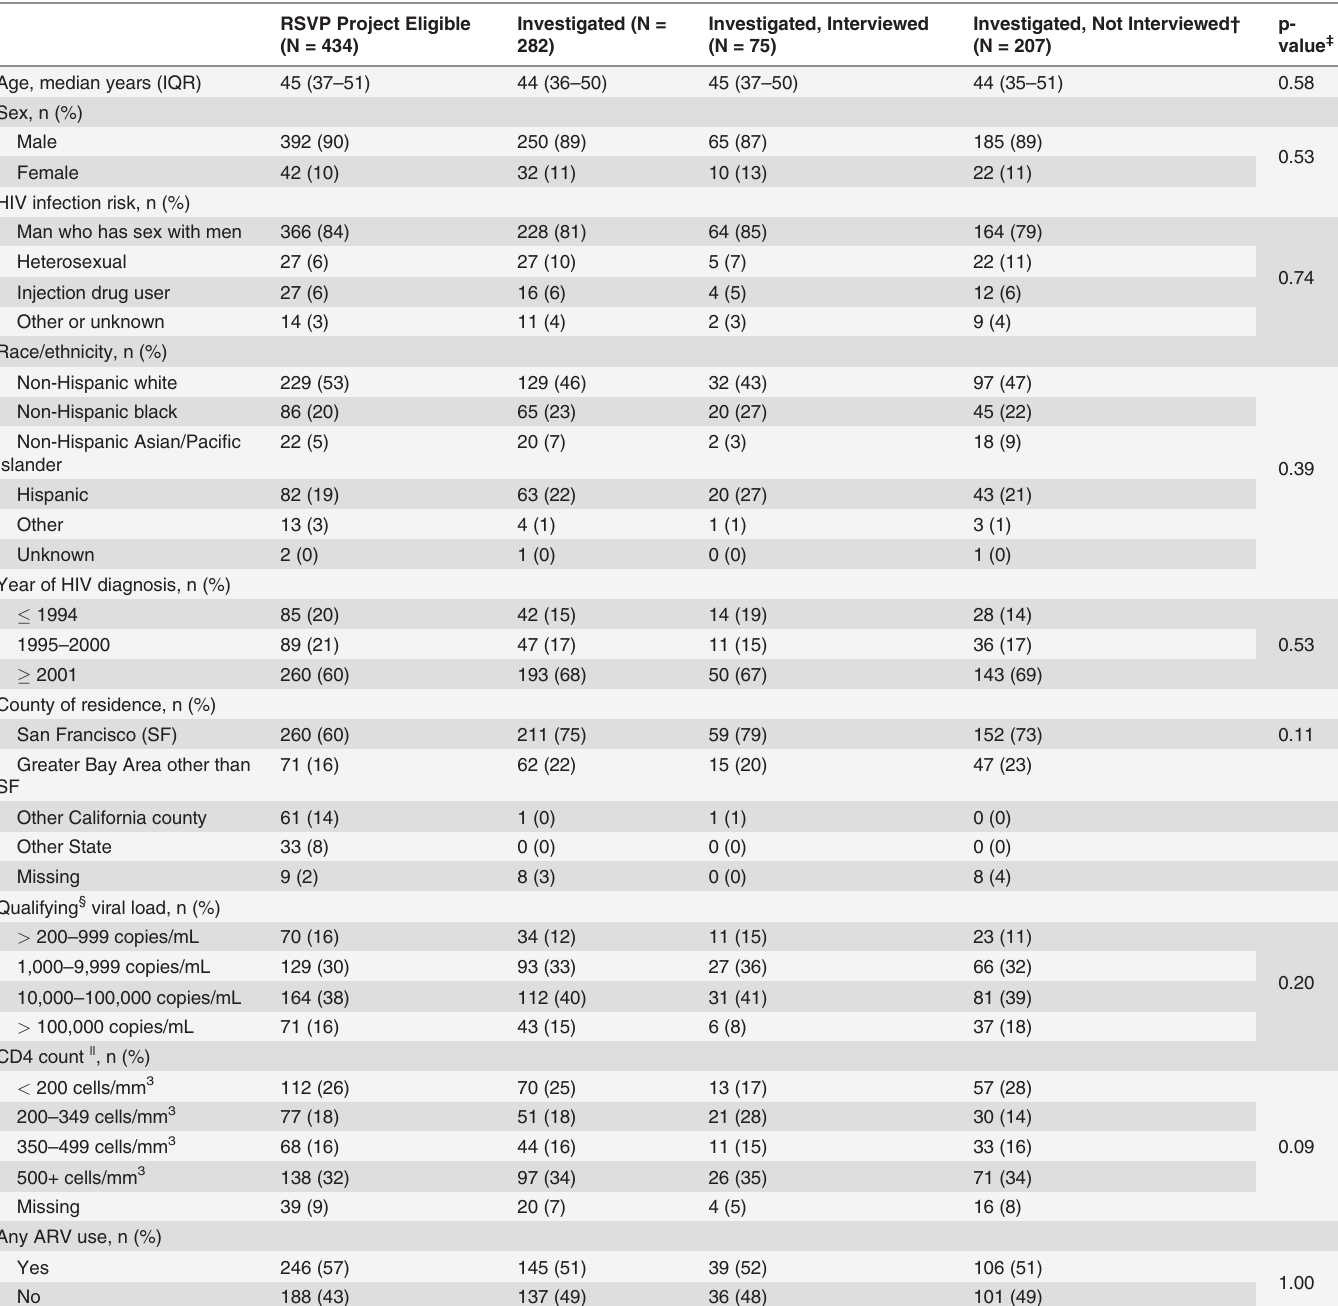
Table 1. Characteristics * of the eligible population and investigated cases, the RSVP project, San Francisco, 2012 –